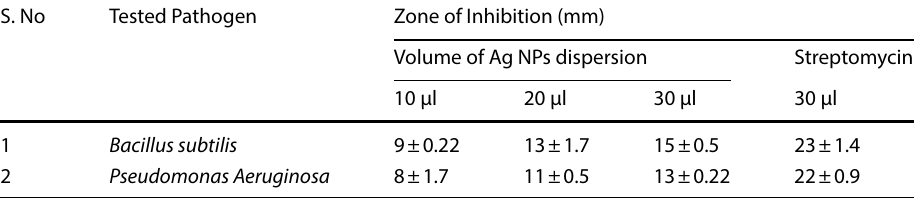
Table 1 Results of Antimicrobial activity of synthesized AgNPs